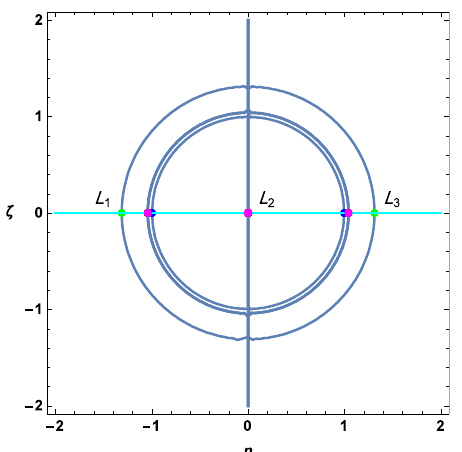
Fig. 4 The locations of lagrangian points during out of plane motion (i.e. ξ = 0 , η (cid:54) = 0 , ζ (cid:54) = 0) in five cases: (a). Third primary is placed at one of the lagrangian points of the classical circular restricted three-body problem (points with blue color), (b). Variation of masses (points with green color), (c). Solar radiation pressure (points with red color), (d). Albedo effect (points with black color), (e). Oblateness effect (points with magenta color).